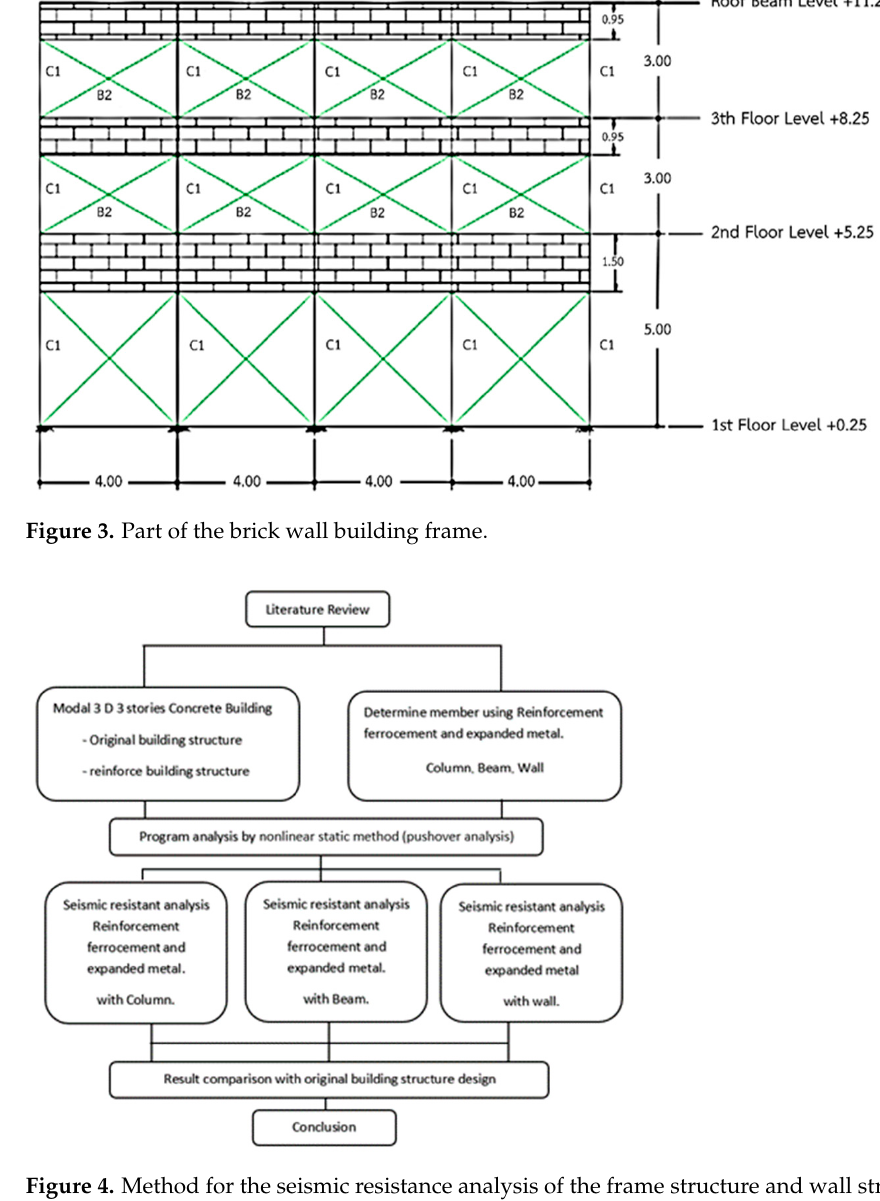
Figure 4. Method for the seismic resistance analysis of the frame structure and wall structure using ferrocement and expanded metal.